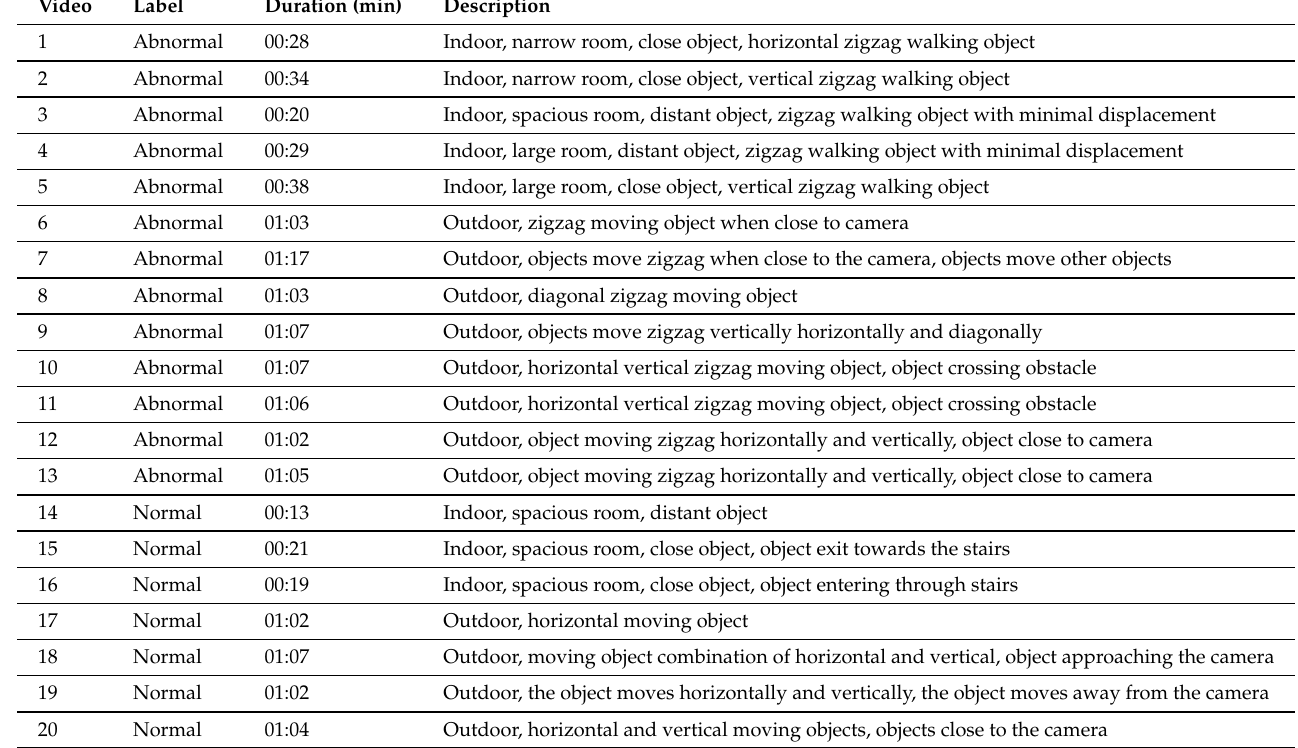
Table 1. Video data